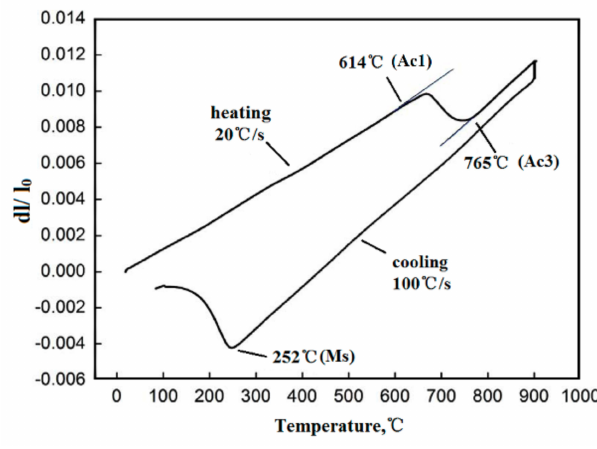
Figure 1. Dilatometric curves for the experimental steel.